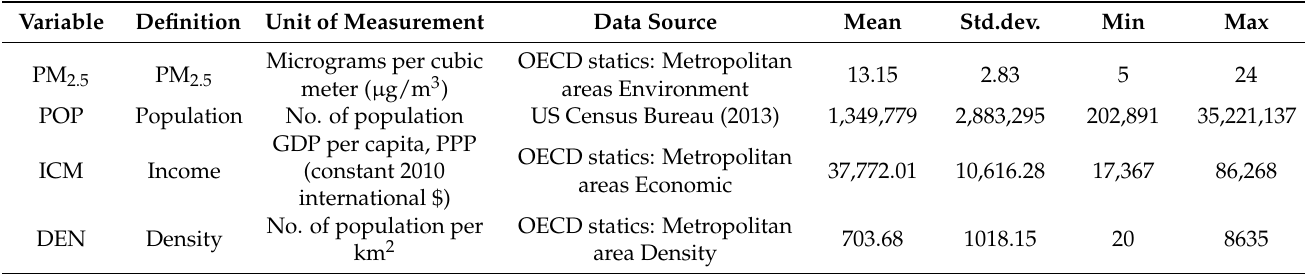
Table 1. Data sources for 254